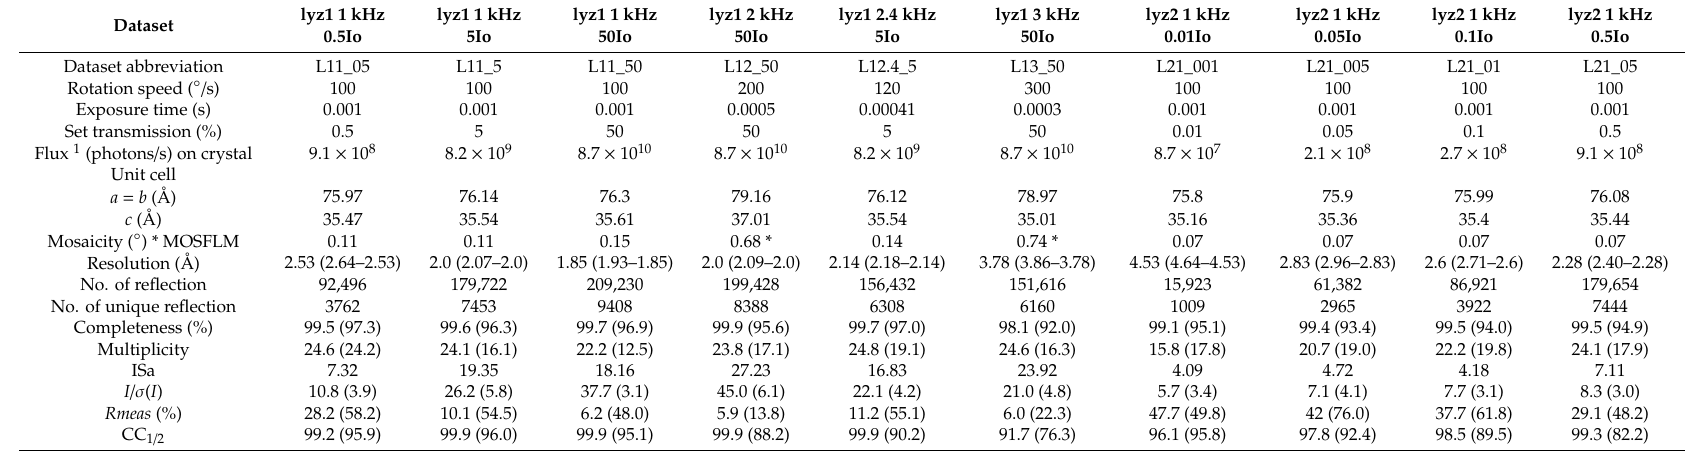
Table 1. Details of experimental data and data reduction results. The results for lyz1 2 kHz and lyz1 3 kHz were obtained with iMOSFLM, and the others were obtained with XDS. The space group of the crystals in all cases is P4 3 2 1 2. The X-ray energy 10.836 keV, sample temperature 100 K, total rotation range 360 ◦ , rotation range per image 0.1 ◦ , number of images 3600. The crystal detector distance was 60 mm for lyz1 and 50 mm for lyz2. The data in parenthesis corresponds to the highest resolution